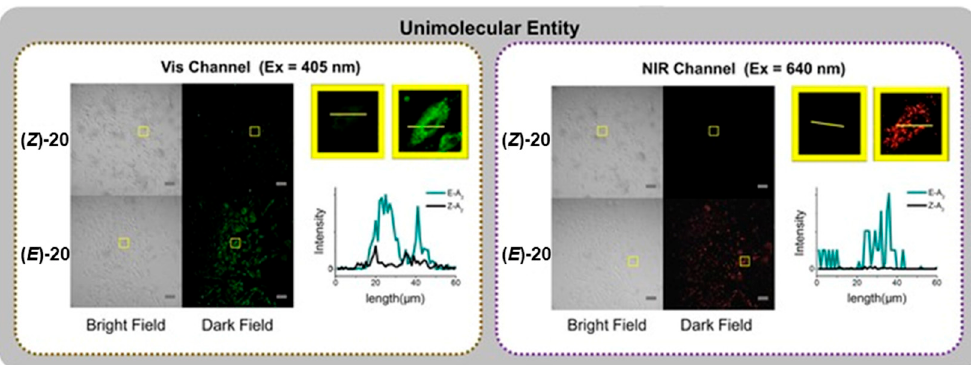
Figure 17. Selective cell imaging of ( Z )-20 and ( E )-20 in either the visible or NIR region in MC3T3-E1 cells. Reproduced with permission from ref. [85]. Copyright 2017 Wiley–VCH Ver- with permission from ref. [85]. Copyright 2017 Wiley–VCH Verlag GmbH & Co. KGaA, lag GmbH & Co. KGaA, Weinheim.